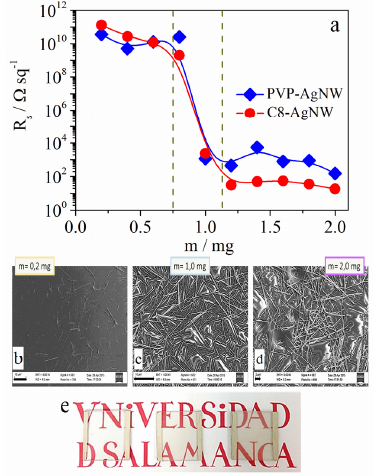
Figure 1. ( a ) Variation of R s with the nanowire mass: PVP ‐ AgNWs (Diamonds) and C8 ‐ AgNWs (circles); ( b – d ) Field Emission ‐ Scanning Electron Microscope (FE ‐ SEM) images and pictures ( e ) of the C8 AgNWs films of different sprayed mass values. Scale length in figures b, c, and d corresponds to 10 μ m, 10 μ m and 2 μ m, respectively.